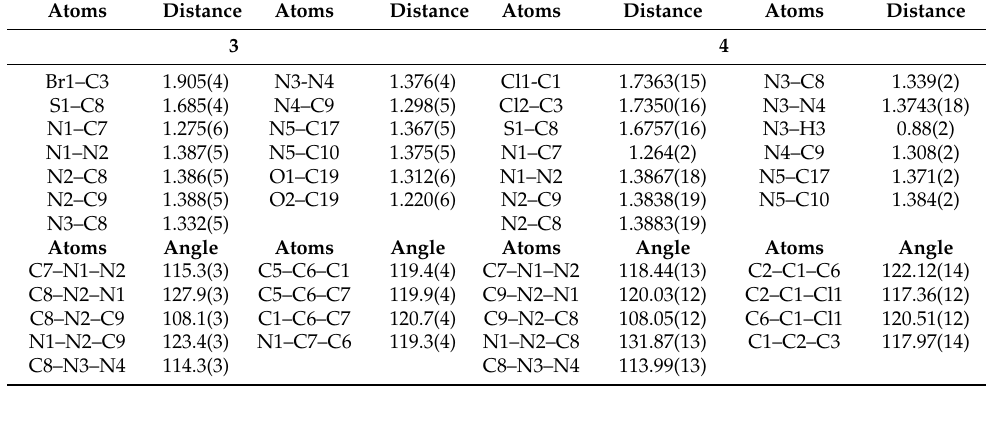
Table 2. Selected bond lengths [Å] and angles [ ◦ ] for 3 and 4 .